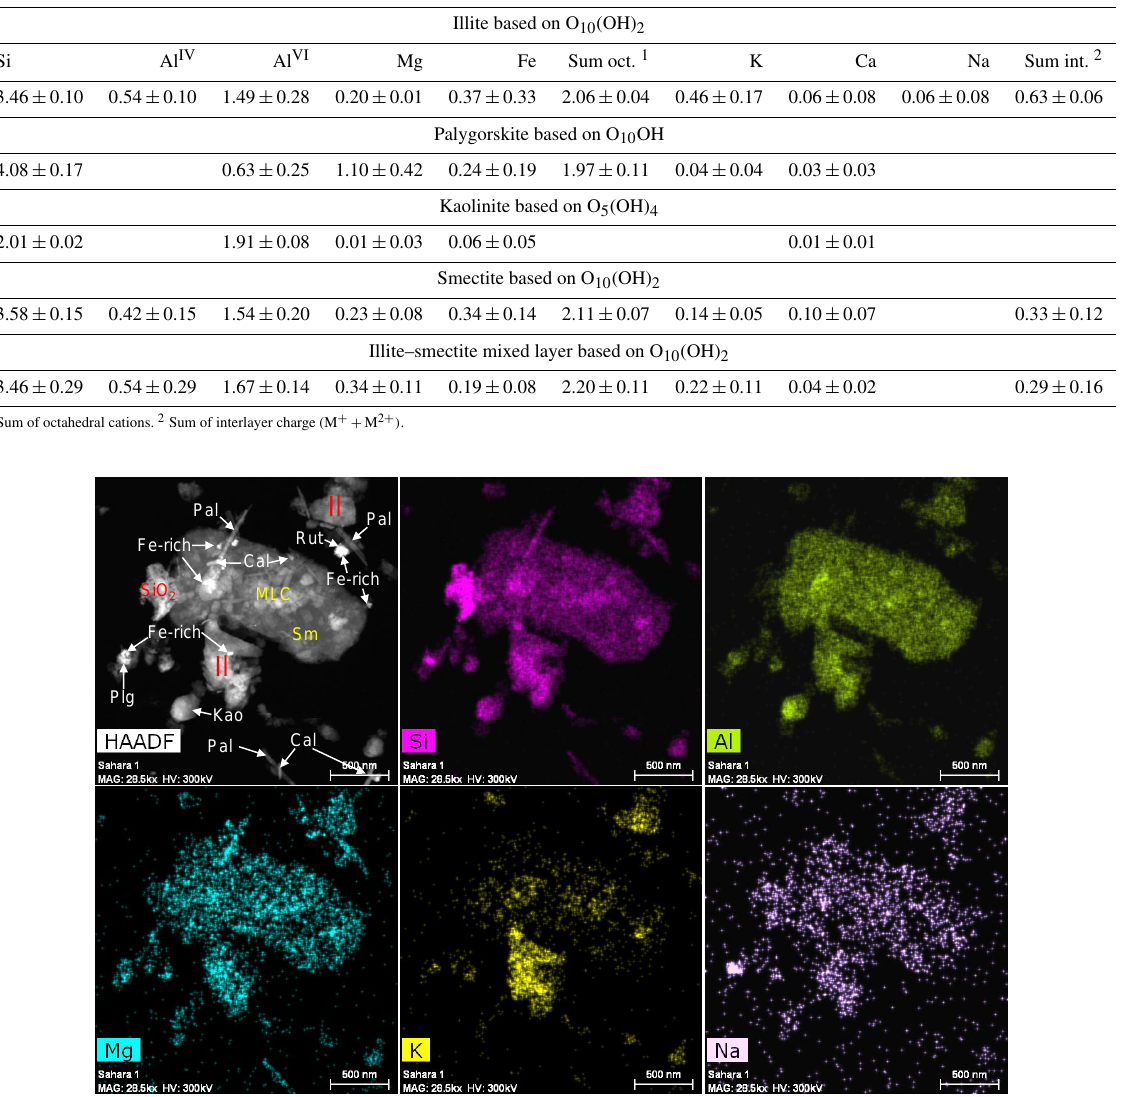
Table 4. Structural formulae of clay minerals in Saharan dust from TEM–AEM analysis.